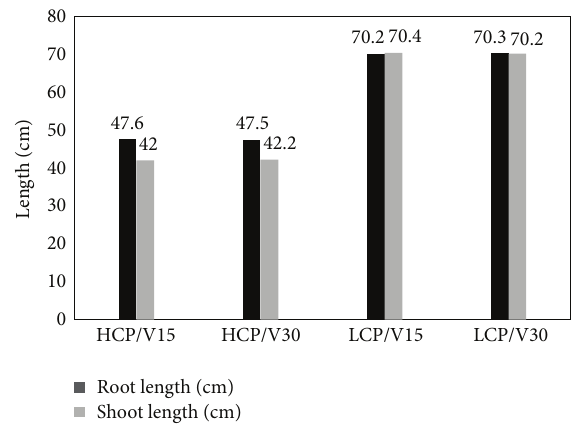
Figure 7: Tillers and leaves increase in Vetiver (HCP is high concentration POME and LCP is low concentration POME).